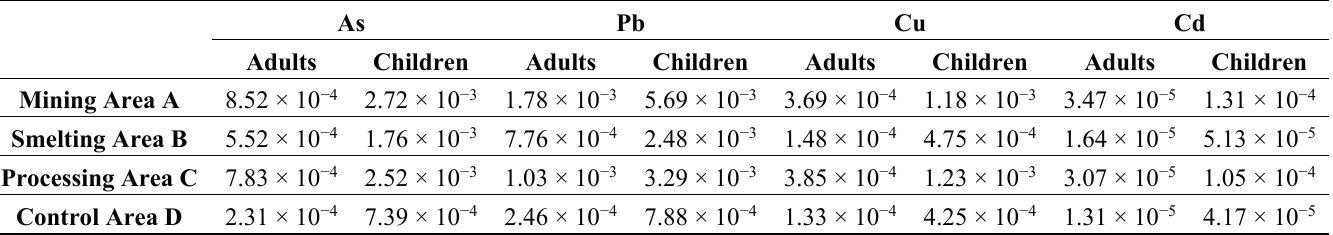
Table 8. Daily soil intake of heavy metals; exposure per day/(mg/(kg·d)).